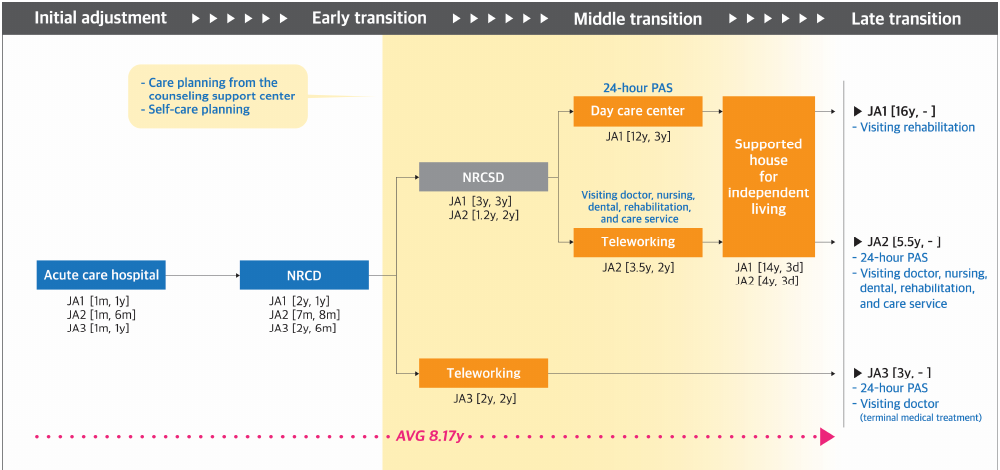
Figure 2. Pathway mapping for Japanese individuals with acquired disability. NRCD, National Rehabilitation Center for Persons with Disabilities; NRCSD, National Rehabilitation Center for Persons with Severe Disabilities; PAS, personal assistance services. Note. Blue, orange, green and grey color in the square respectively indicate facilities providing medical, welfare, education, and mixed medical and welfare related services. Code and number indicate participant code [the time taken to begin using the facility, the period of use] (Ex. JA1 [3y,